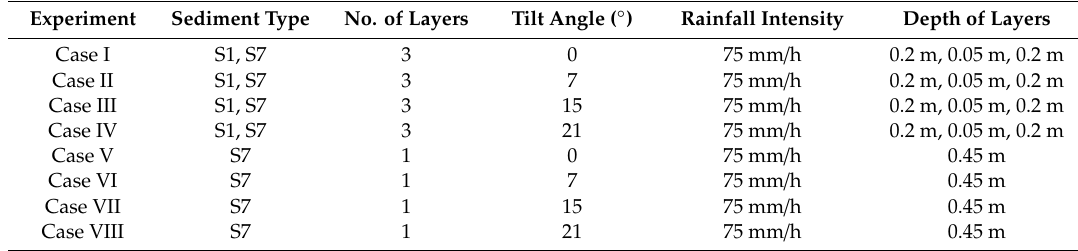
Table 3. General information for the slope model experiment.